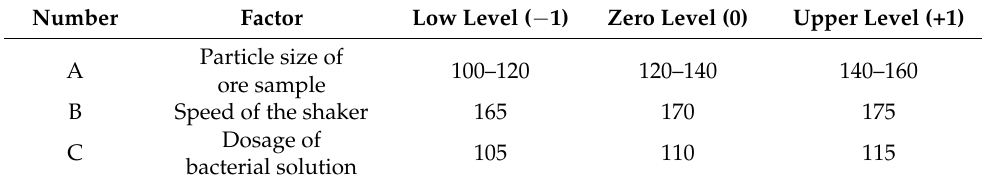
Table 3. Experimental level design for the Box–Behnken